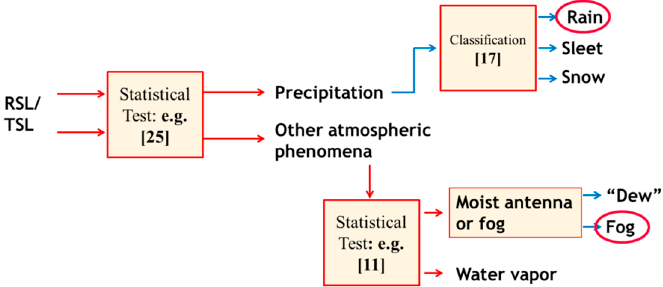
Figure 2. A possible workflow for a commercial microwave link (CML) based environmental monitoring, where the input is the transmitted/received signal level measurements (TSL/RSL) (after O. Harel).